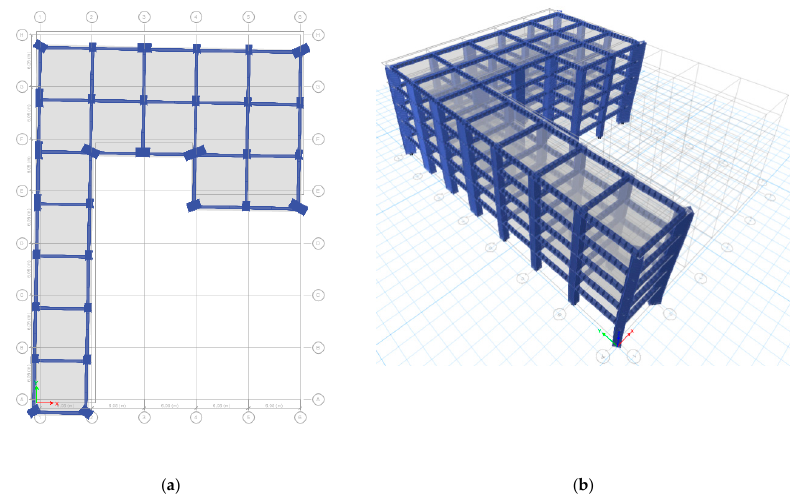
Figure 10. The 1st mode shape for T 1 = 0.414 s: ( a ) plane view, and ( b ) 3D view.